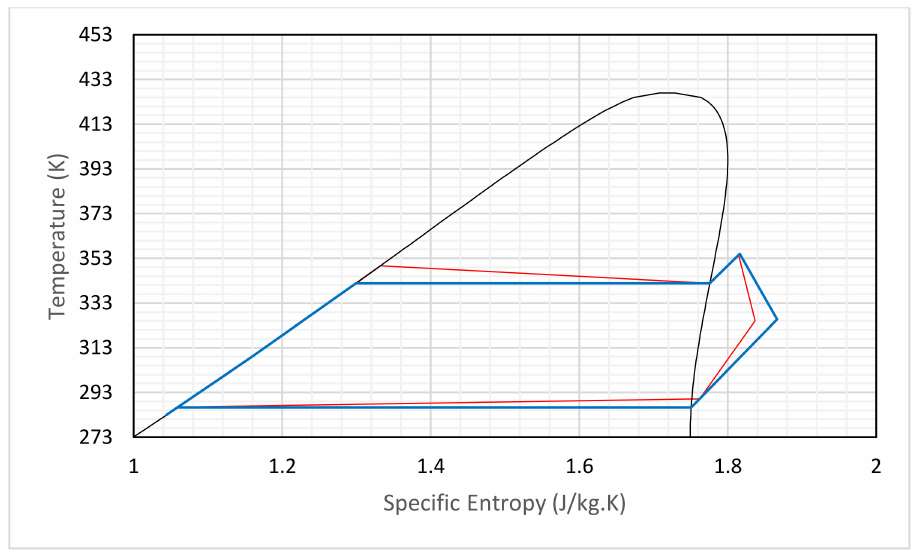
Figure 3. Comparative T-s diagrams of the highest e ffi ciency case, and the theoretical prediction for these parameters. The theoretical case is indicated by a blue line, and the experimental case is indicated by a red line.